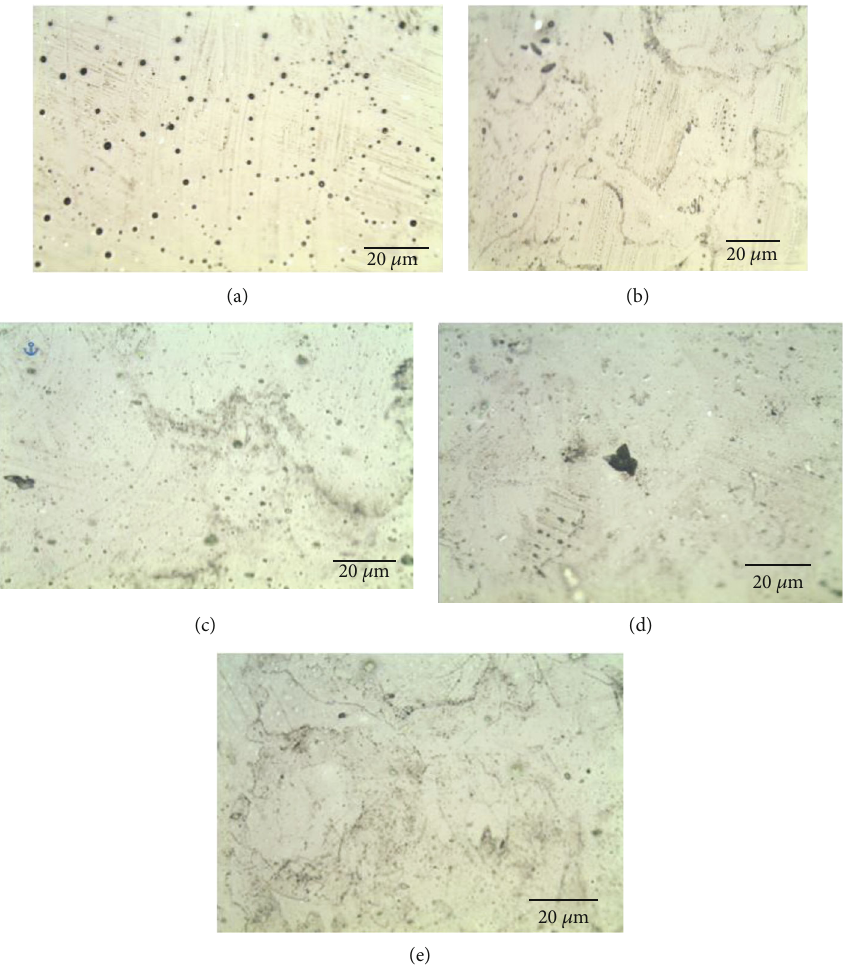
Figure 8: Optical image of (a) neat epoxy, (b) EP1, (c) EP3, (d) EP5, and (e) EP7